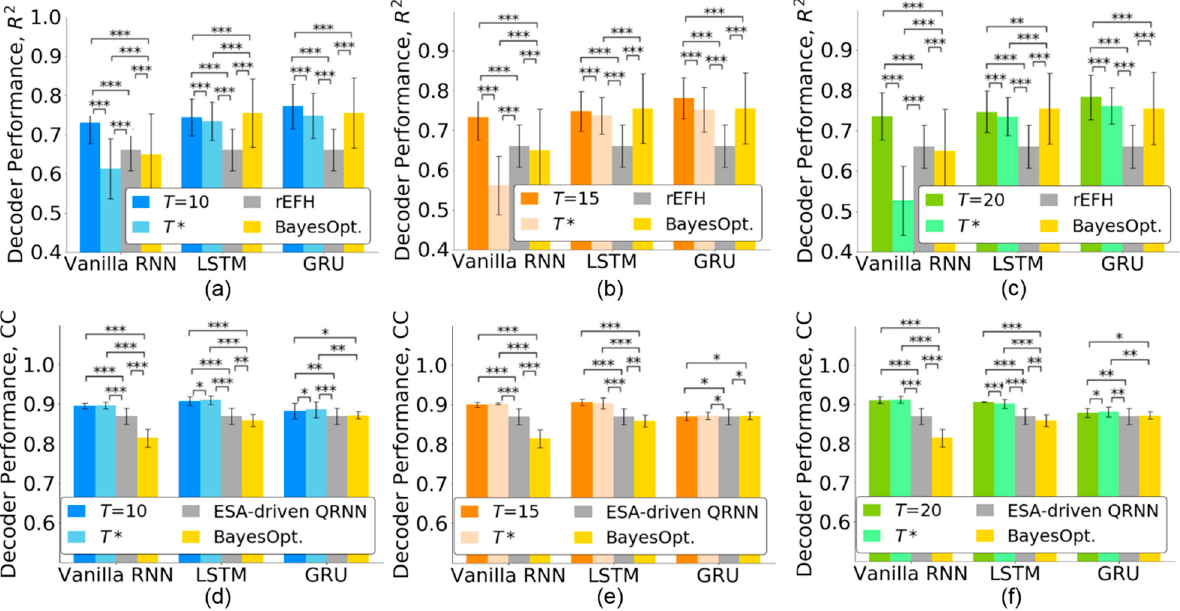
Figure 6. Decoding performance of the state-of-the-art methods for the monkey Indy (top row) and monkey N (bottom row) data. The neural decoders were first trained with T timesteps and then retrained with T ∗ timesteps. ( a , d ) T = 10. ( b , e ) T = 15. ( c , f ) T = 20. The error bars indicate standard deviations across 37 sessions for the monkey Indy data and across five independent runs for the monkey N data. BayesOpt. represents the Bayesian optimization. The significance levels were set at * p < 0.05, ** p < 0.01, and *** p < 0.001.